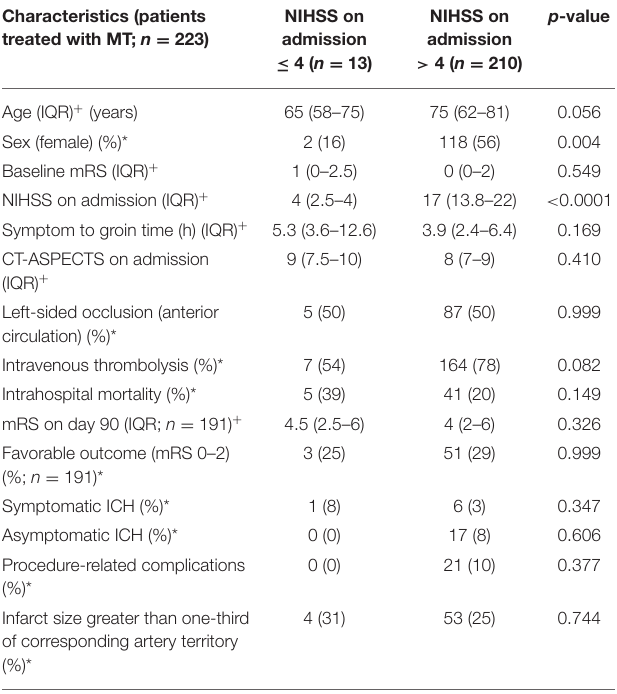
TABLE 4 | Characteristics of patients treated with MT with NIHSS ≤ 4 and > 4 on admission. Characteristics (patients treated with MT; n =